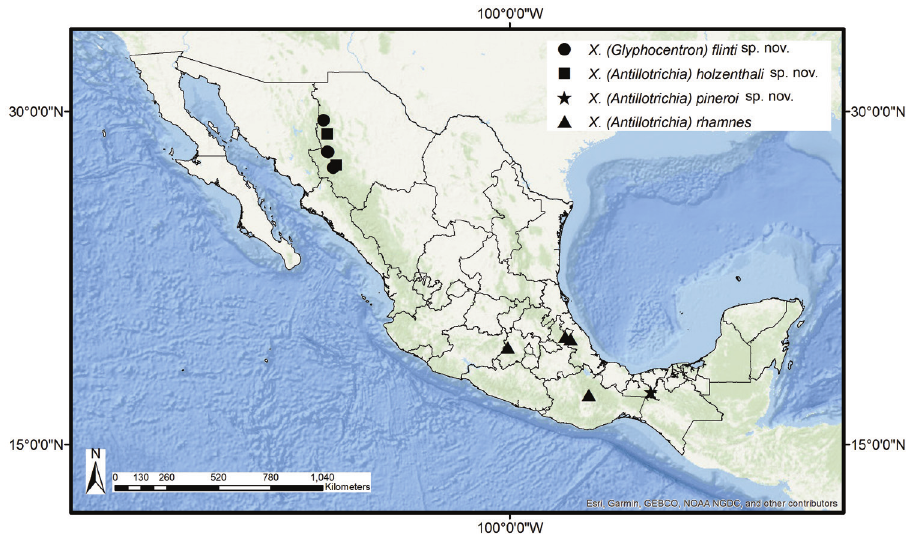
Figure 6. Mexican distribution of the new species of Xiphocentron and X . ( Antillotrichia ) rhamnes Schmid,